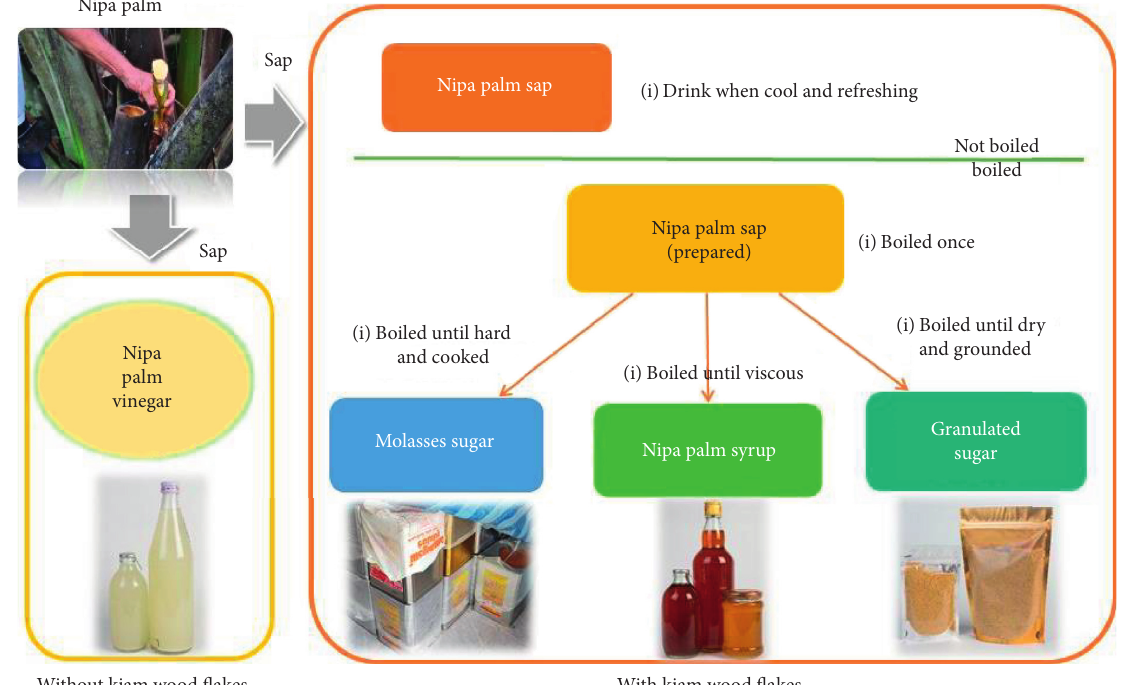
Figure 4: Sap processing into various products using traditional extraction